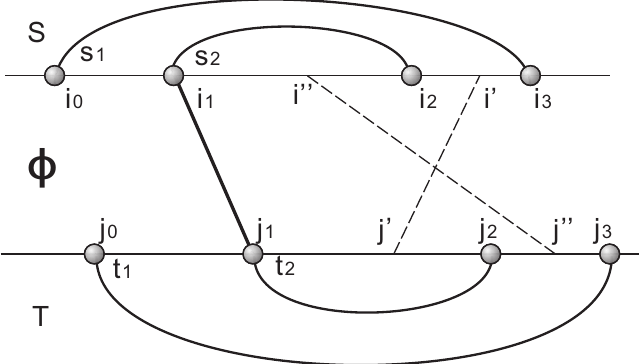
Figure 2. Any 3-simplex contains a free mixed 1-face. The loops s 1 , s 2 , t 1 , t 2 have the covering